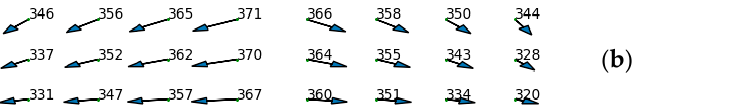
Figure 6. Calculation of Exact Shortest Distance from Any Point in the Map. ( a ) Case I, ( b ) Case II.